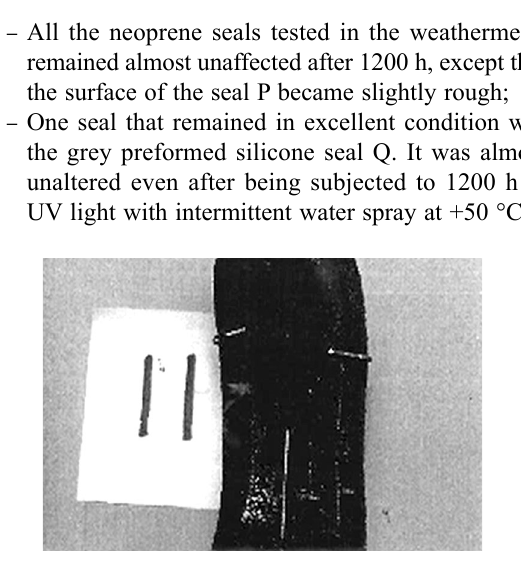
Fig. 7. Grey side of preformed seal K exposed to UV light and intermittent water spray after